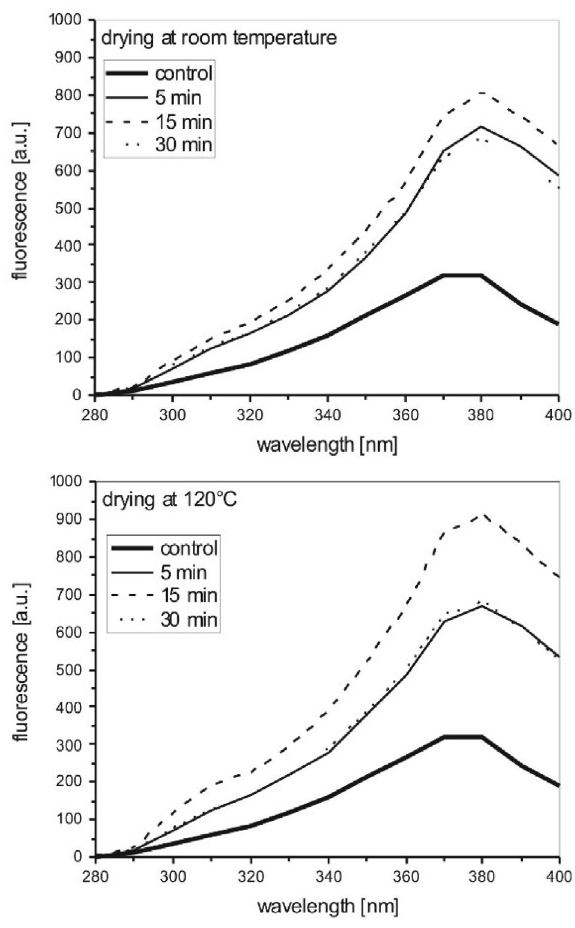
Figure 11. Fluorescence activation spectra of the prepared textiles. The activation is recorded for fluorescence light emitted at 440 nm. Presented are textiles prepared with solutions realized with differ- ent process duration under a process temperature of 140 °C. After solution application the textile samples are dried at room tempera- ture or at 120 °C.